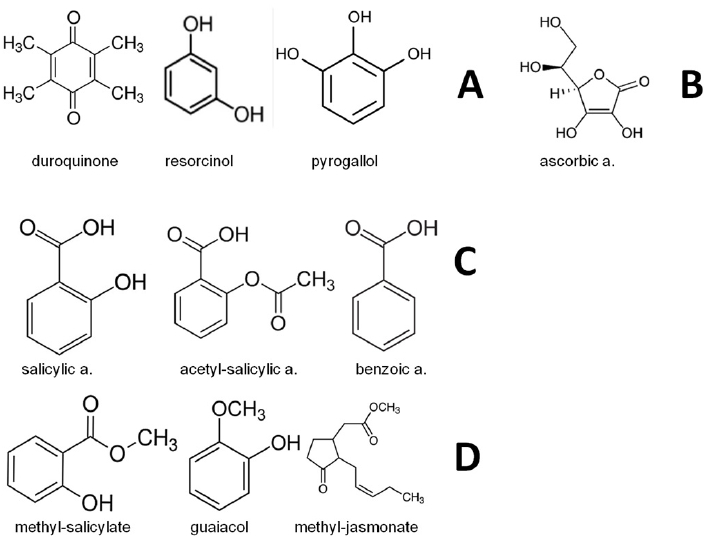
Figure 2. Chemical structures of the antioxidant compounds provided to plants as activators of defense against RKNs. ( A ) Hydro-benzenic species; ( B ) ascorbic acid; ( C ) phenolic acids; ( D ) methylated species. Four different types of antioxidants were used: (Figure 2A) hydro-benzenic species (duroquinone “DQ”, resorcinol “RESO”, pyrogallol “PYRO”); (Figure 2B) ascorbic acid “ASC”; (Figure 2C) phenolic acids (salicylic “SA”, acetyl-salicylic “AcSA”, benzoic “BA”); (Figure 2D) methylated species (methyl-salicylate “MetSA”, guaiacol “GUA”, methyl- jasmonate “MetJA”). Applied dose ranges, type of application, treated plant species, and type of solvent for each tested antioxidant are shown in Table